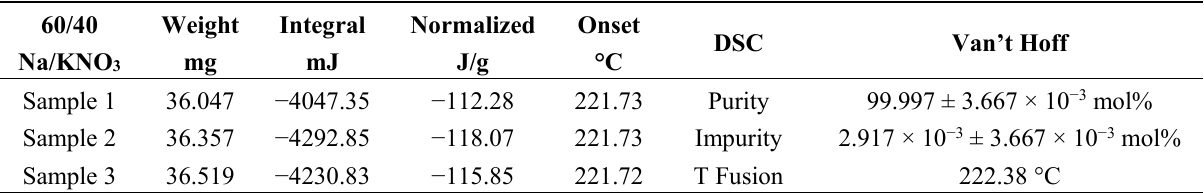
Table 1. DSC results of eutectic mixture of sodium and potassium nitrate (60/40 ratio). Purity of the sample was determined to be